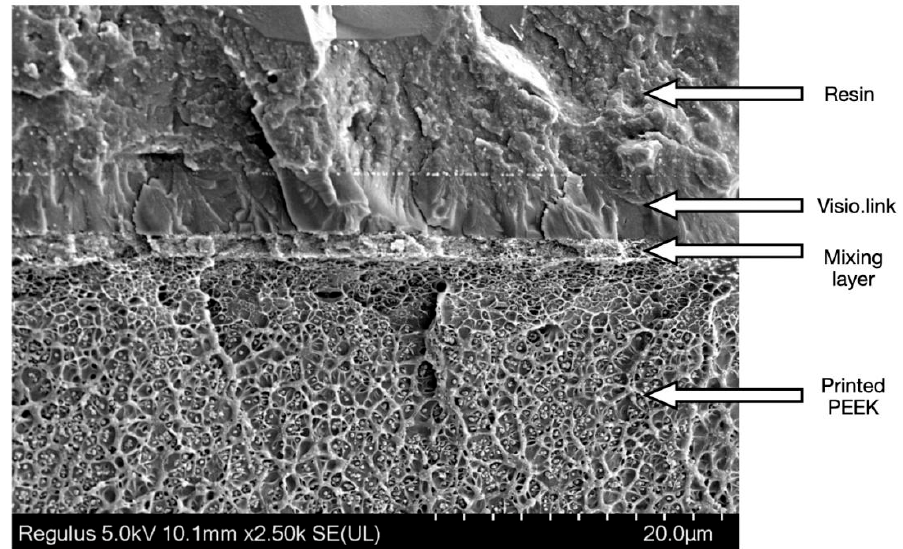
Figure 8. The typical bonding interface between the printed PEEK (etching for 5 s) and the veneering resin by the mediation of the primer Visio.link. Layers were labeled